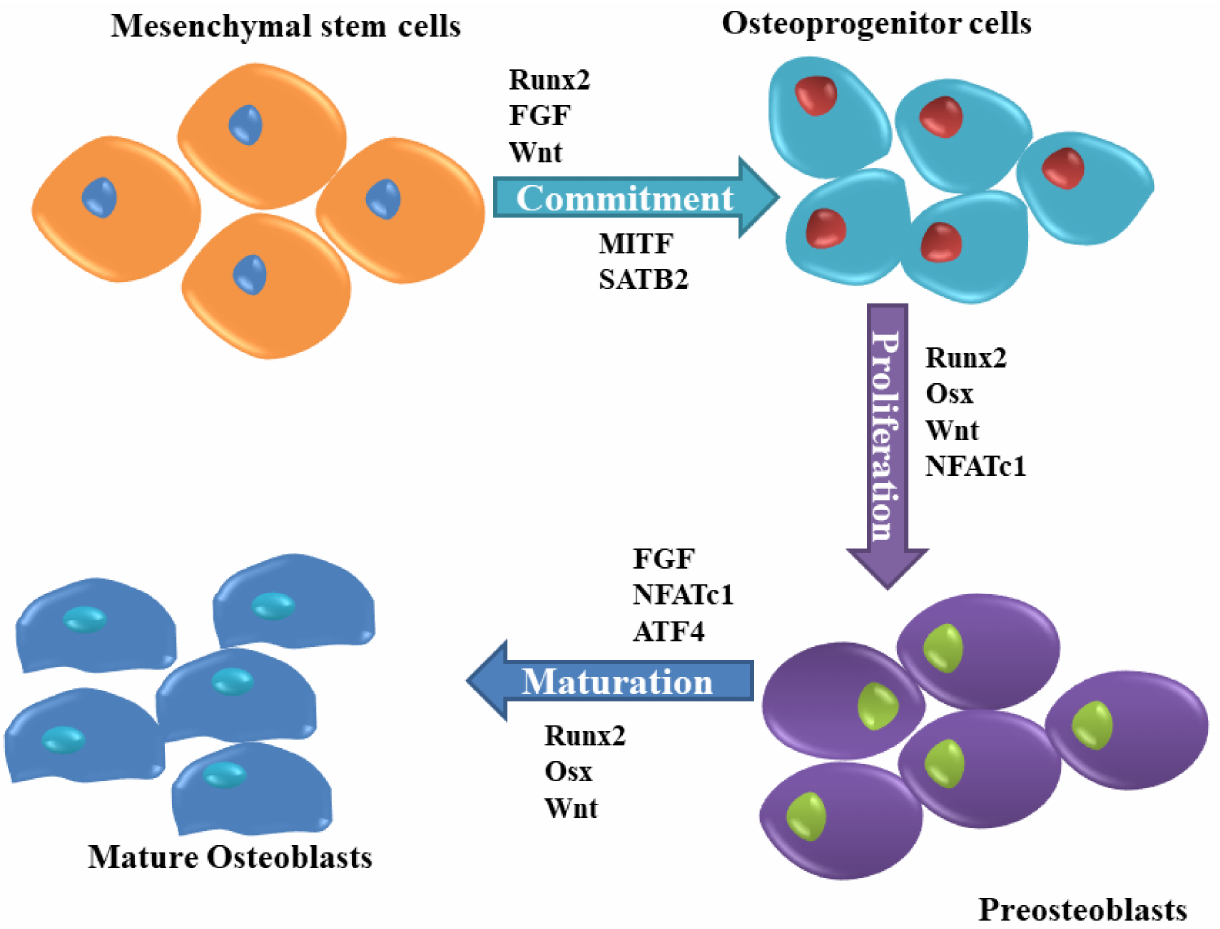
Figure 2. Molecules responsible for osteoblast differentiation. The commitment of mesenchymal stem cells to osteogenic progenitor cells is influenced by Runx2, FGF, Wnt, as well as MITF and SATB2, while Osx, Runx2, NFATc1 promote osteogenic progenitor cell proliferation to preosteoblasts, which is then muture into mature and functional osteoblasts by the action of Runx2, FGF, Wnt, NFATc1, MITF as well as